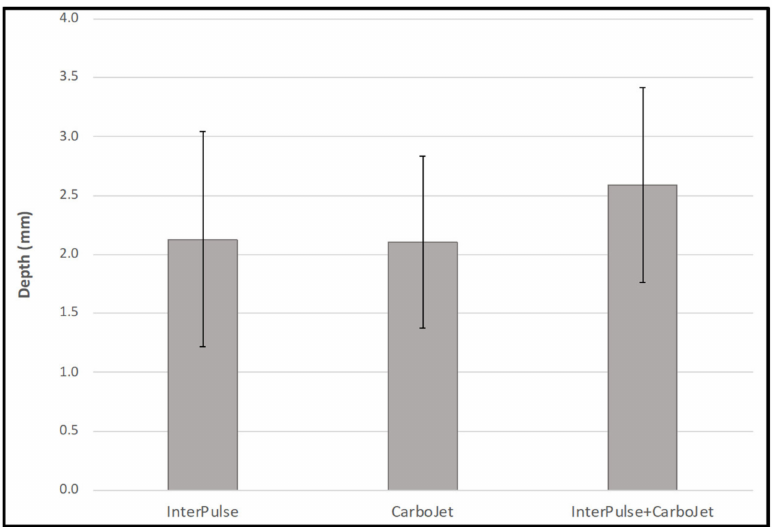
Figure 7. Cleaning depth in mm in standardized carbon foam